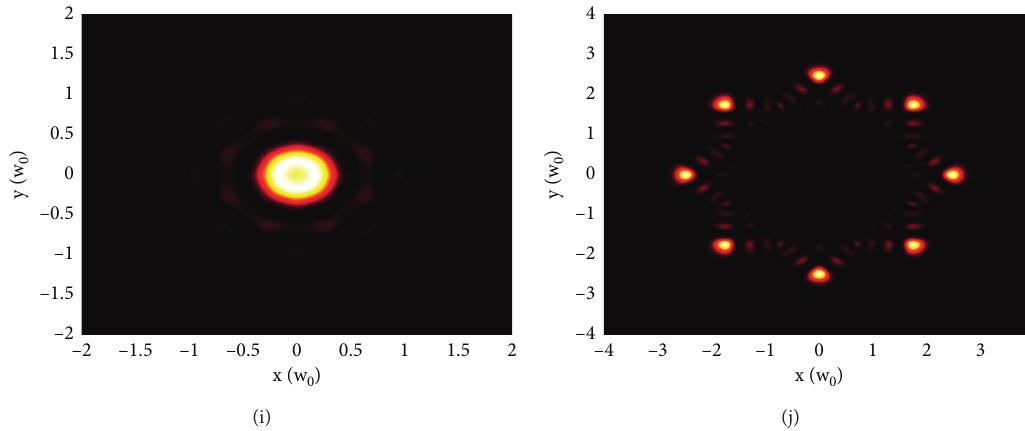
Figure 5: Transverse intensity distribution of PCAFABs in atmospheric space for different value of ( n ); other parameters are the same as those in Figure 4(a), and two blue arrow heads denote the initial transverse displacement and angle displacement between two incoming Airy beams, respectively: (a) ( n ) � 2, ( z ) � 0m; (b) ( n ) � 2, ( z ) � 500m; (c) ( n ) � 3, ( z ) � 0 m; (d) ( n ) � 3, ( z ) � 500m; (e) ( n ) � 6, ( z ) � 0m; (f) ( n ) � 6, ( z ) � 500m; (g) ( n ) � 8, ( z ) � 0m, first kind; (h) ( n ) � 8, ( z ) � 500m, first kind; (i) ( n ) � 8, ( z ) � 0 m, second kind; (j) ( n ) � 8, ( z ) � 500m, second